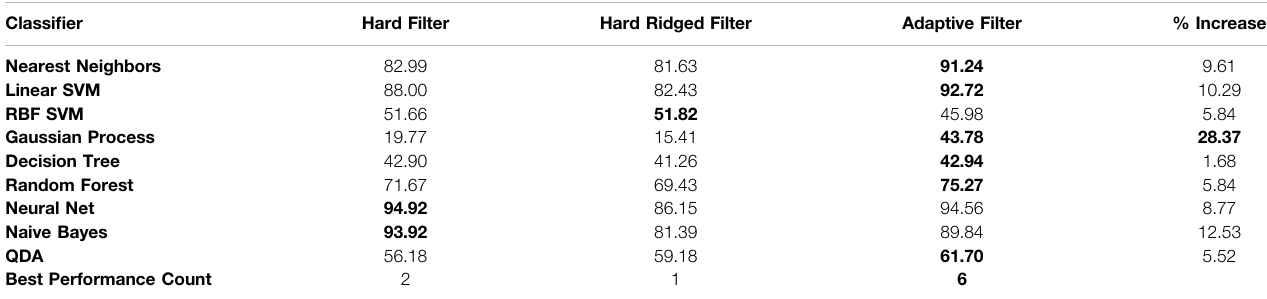
TABLE 2| Accuracyof9classi fi erstodiscriminate across17objects.Each oftheaccuraciesreportedareaveragedacross50runs. Eachruncorresponds totherespective classi fi er fi t on PCA projected tactile data from 1 up to 50 dimensions. Classi fi er Hard